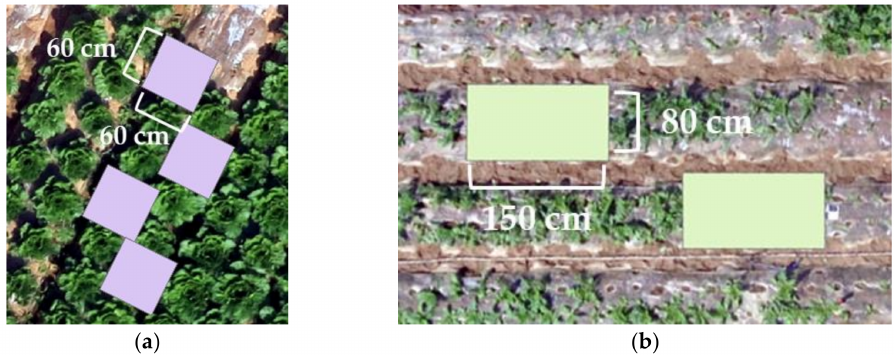
Figure 4. Views of regions of interest (ROIs) selected for extracting the plants of ( a ) Chinese cabbage and ( b ) white